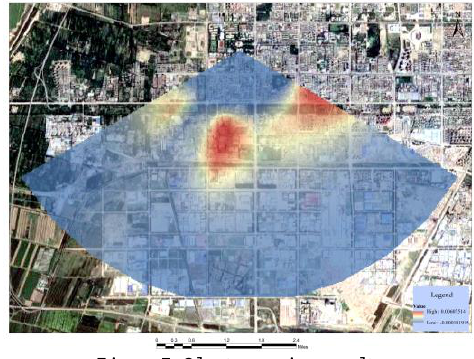
Figure 7. Slant scanning results Figure 6 is the observation results of stagnation points from 17:00 to 24:00 on March 11, 2018. THI map was drawn with 100 sets of observation data. It can be seen from the figure that after 17:00, the area below 2km has darker colors and the upper air has lighter colors. This is because human activities cause the near ground atmosphere to be turbidity. Around 24:00, the